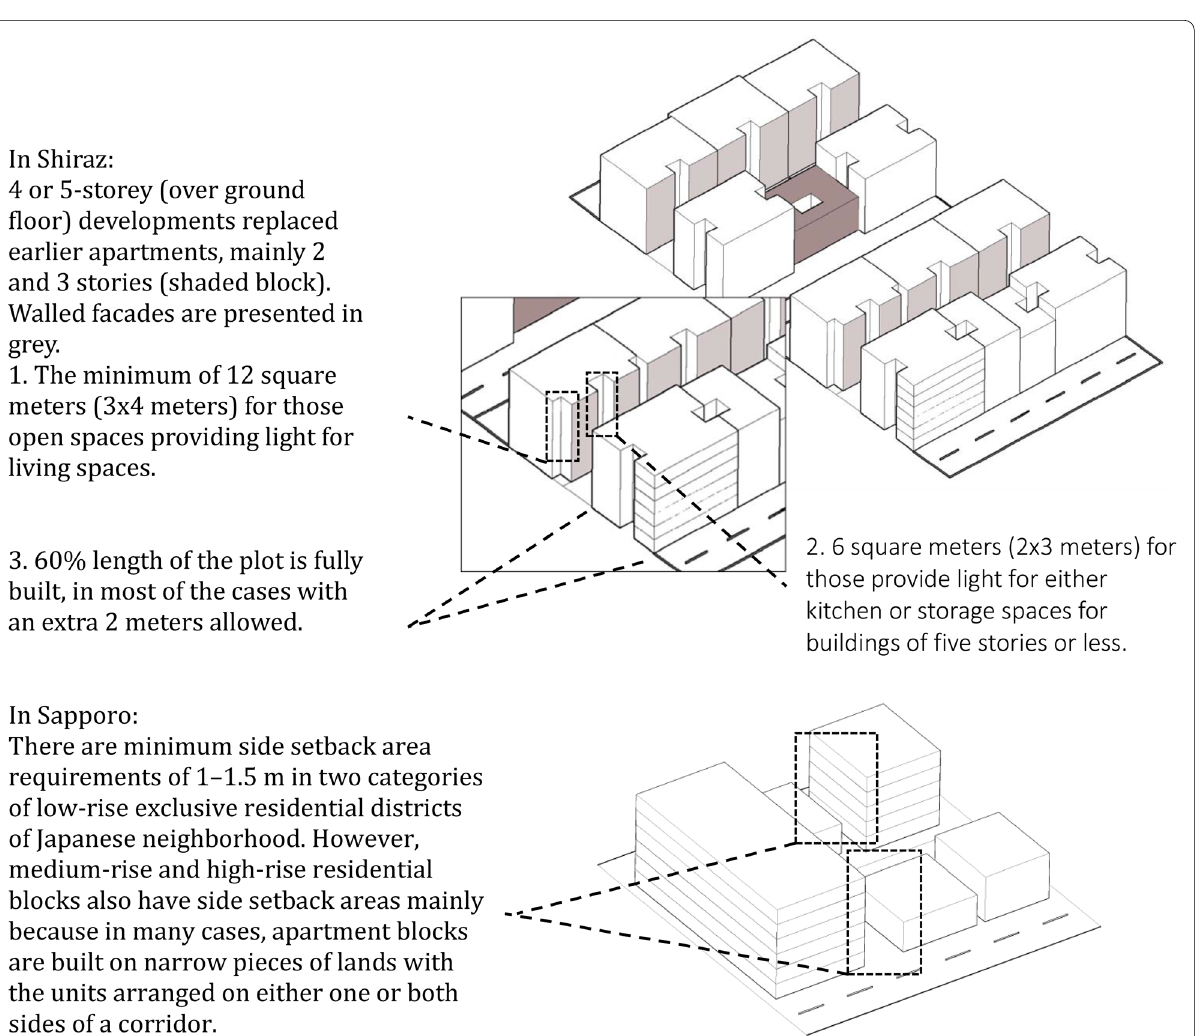
Fig. 3 (Top) Inner courtyards as mere light shafts in housing blocks in Iran, whereas in the Japanese case (Bottom) open spaces are shaped as side setbacks. There is a hypothesis that redistributing the open spaces in Iranian case and introduce wider inner courtyards will contribute to the better ventilation and perception of these open spaces in residential blocks (Bottom)